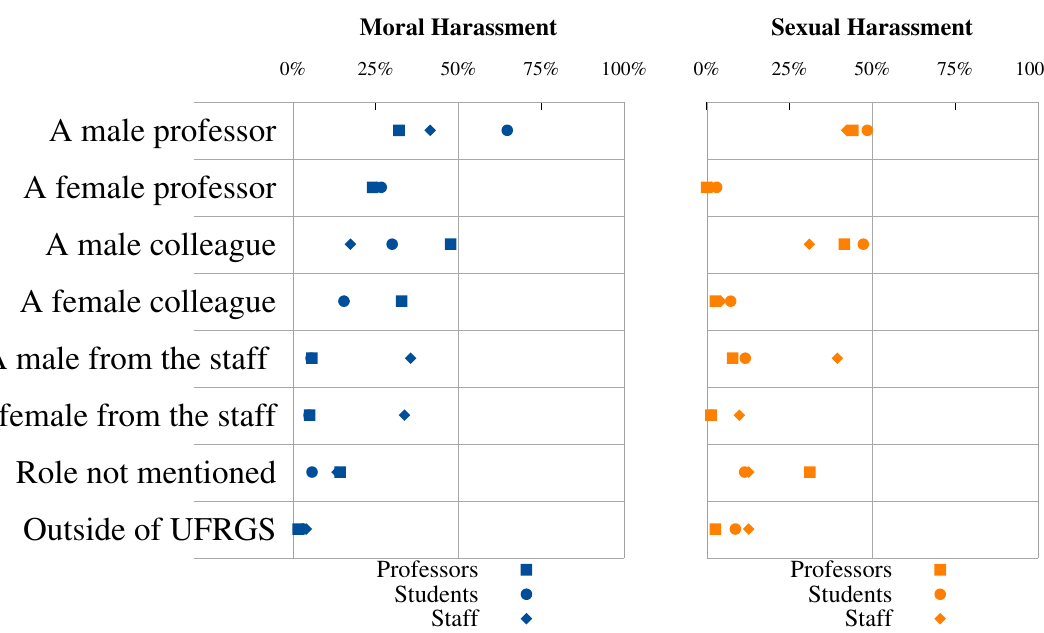
Figure 1. Percentage of people who were victims of moral (left) and sexual (right) harassment by a person indicated in the list on the left. Respondents were allowed to mark more than one option. Different categories are represented in different symbols, which are indicated in the legend.